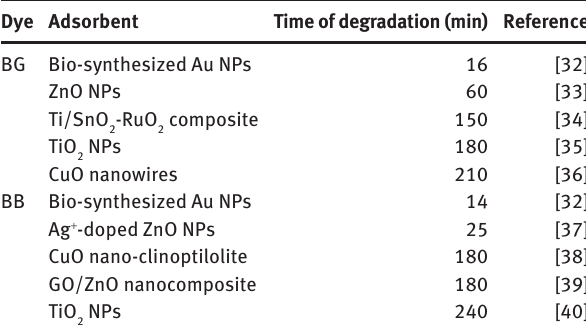
Table 2: Time-dependent photocatalytic degradation of the selected brominated dyes with different materials Dye Adsorbent